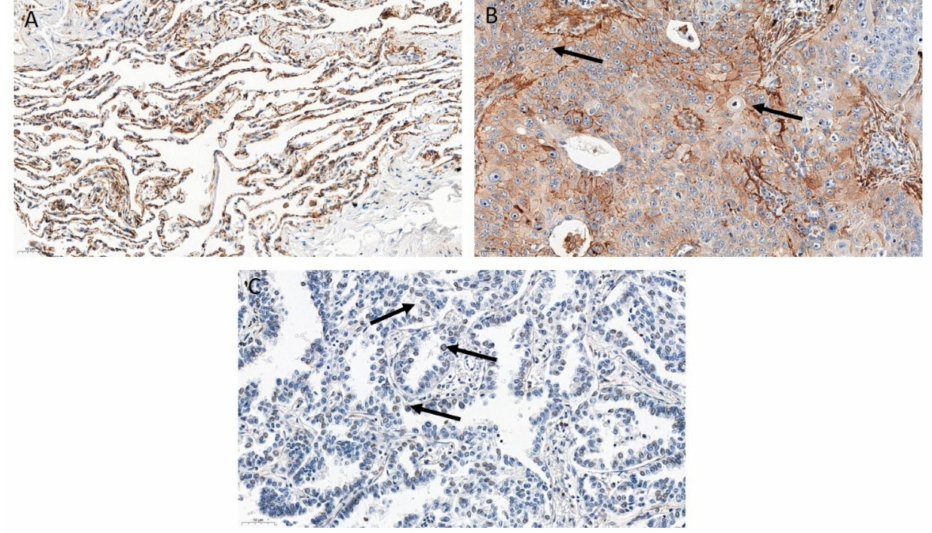
Figure 4. Immunohistochemical (IHC) reactions detecting ZYX protein (brown) performed on non-malignant lung tissue (NMLT) ( A ), lung squamous cell carcinoma (SCC) ( B ), and lung adenocar- cinoma (AC) ( C ). Arrows in ( B ) indicate cytoplasmic/membranous localization of ZYX, while arrows in ( C ) show nuclear one. Magnification ×